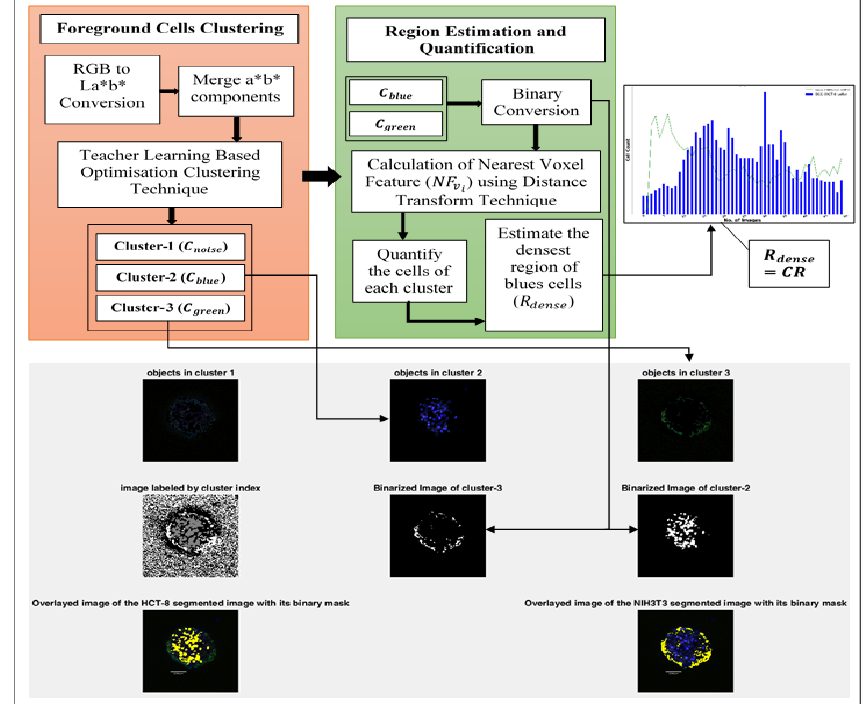
Figure 3. Resultant view of proposed